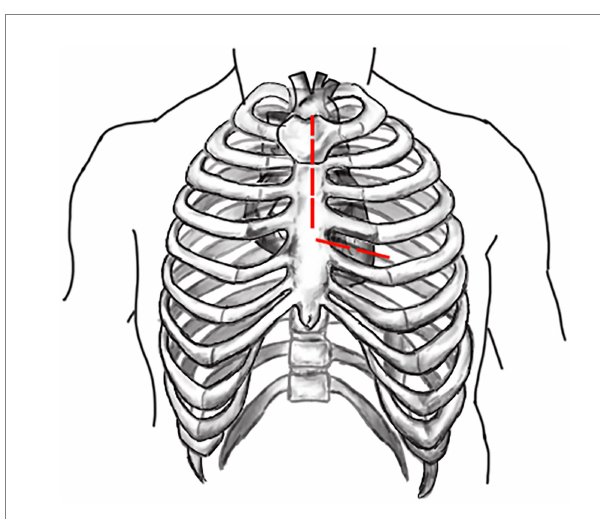
FIGURE 4 Schematic diagram of “L” shaped incision in partial upper sternotomy.